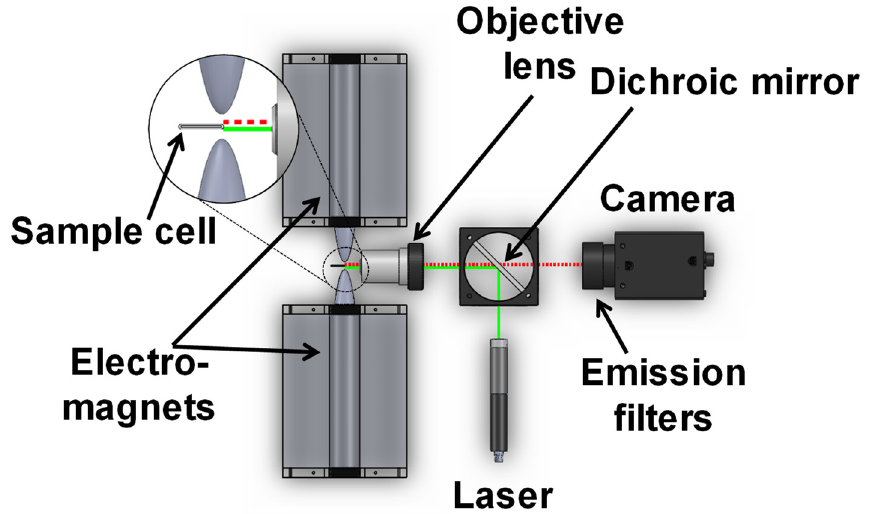
Figure 2. Schematic of a magnetic modulation biosensing (MMB) system.